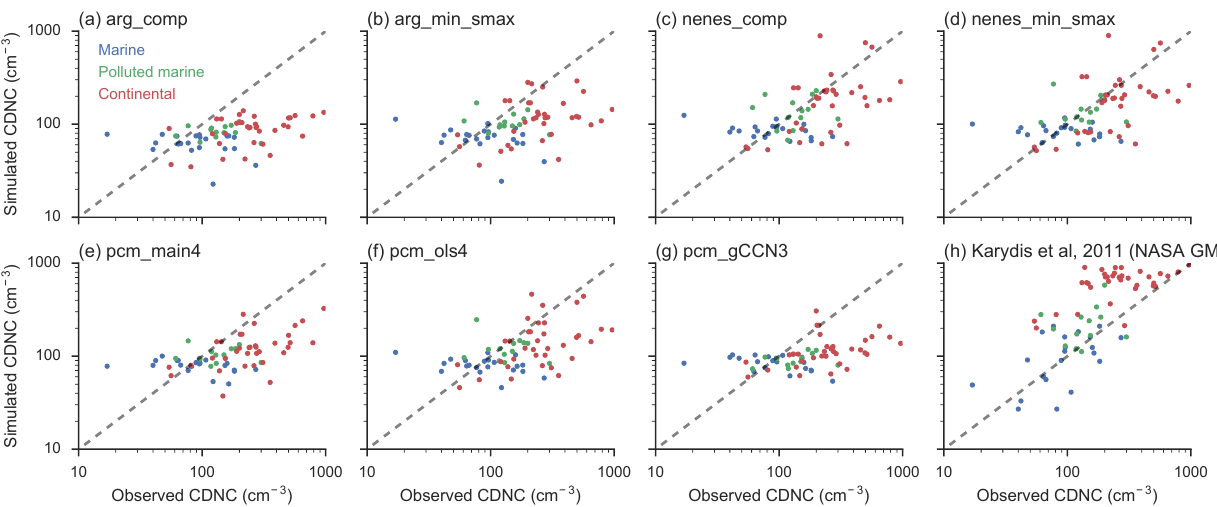
Figure 2. One-to-one comparisons between observed and simulated cloud droplet number concentrations from regions across the globe. Panels (a) – (g) show results from the MARC simulations using the indicated droplet activation schemes; panel (h) shows results of CDNC modeled by a chemical transport model with detailed aerosol and activation treatments.